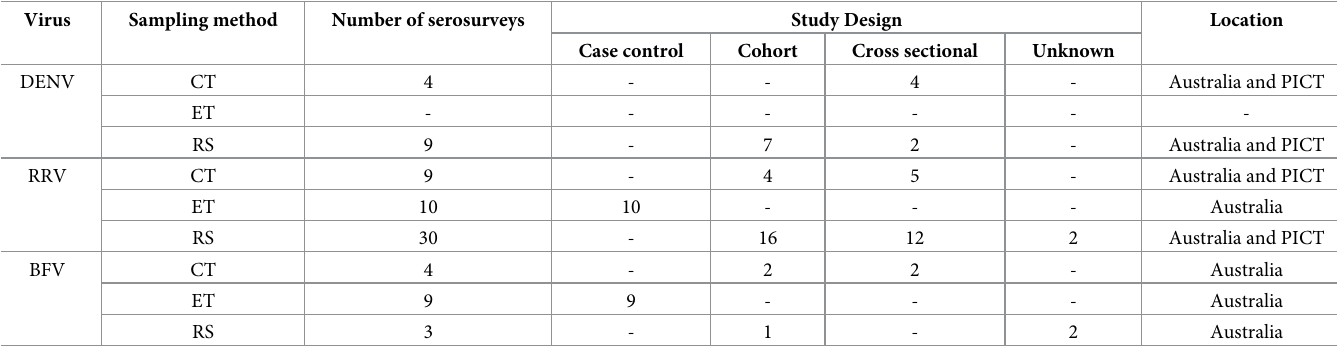
Table 2. Summary of sampling methods, study designs and